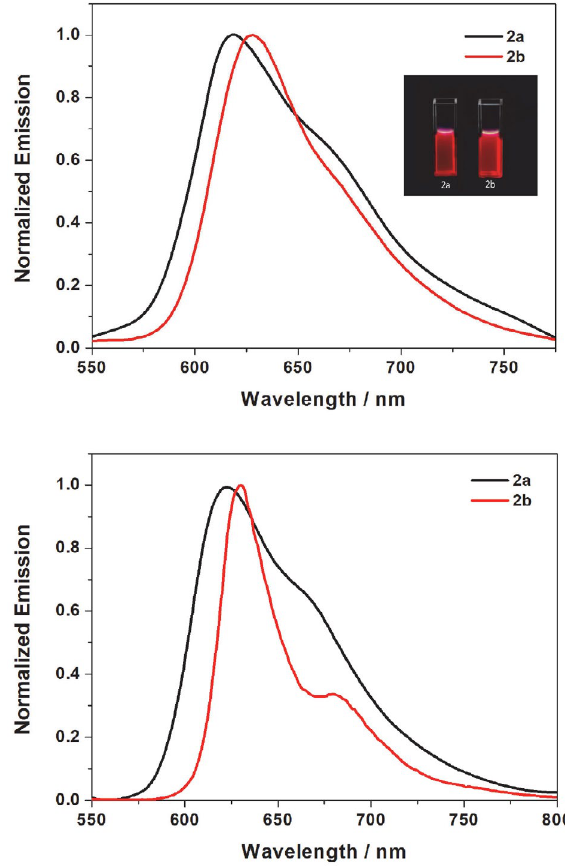
Fig. 3. Normalized emission spectra of 2a – 2b in degassed CH 2 Cl 2 solution at 298 K (left) and 77 K